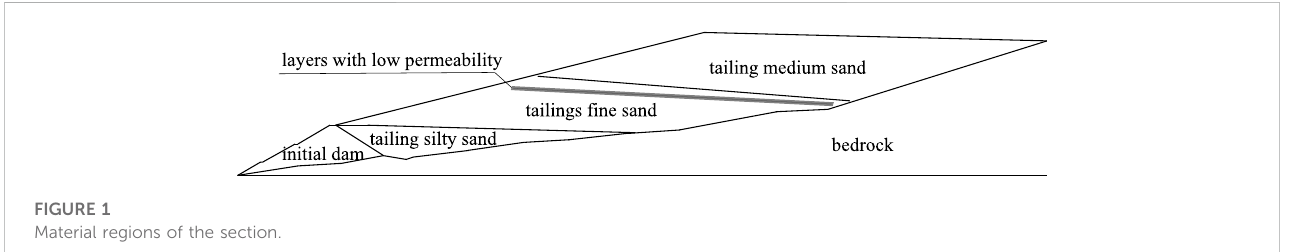
FIGURE 1 Material regions of the